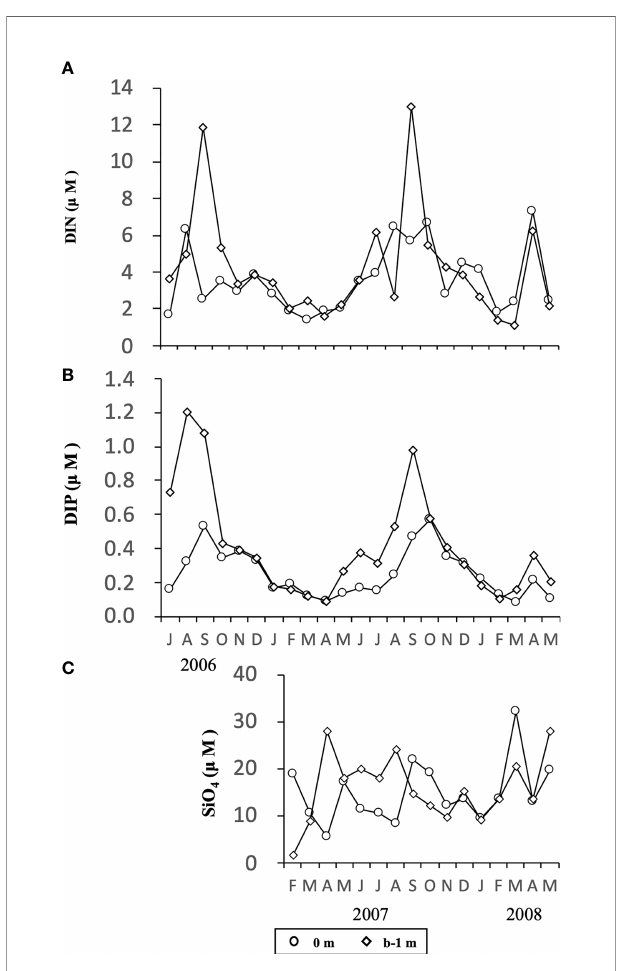
FIGURE 6 | Temporal changes in concentrations of DIN (A) , DIP (B) and SiO 4 (C) at the depth of 0 m and b-1 m at the sampling site in Ago Bay. b-1 m denotes the depth at 1 m above the